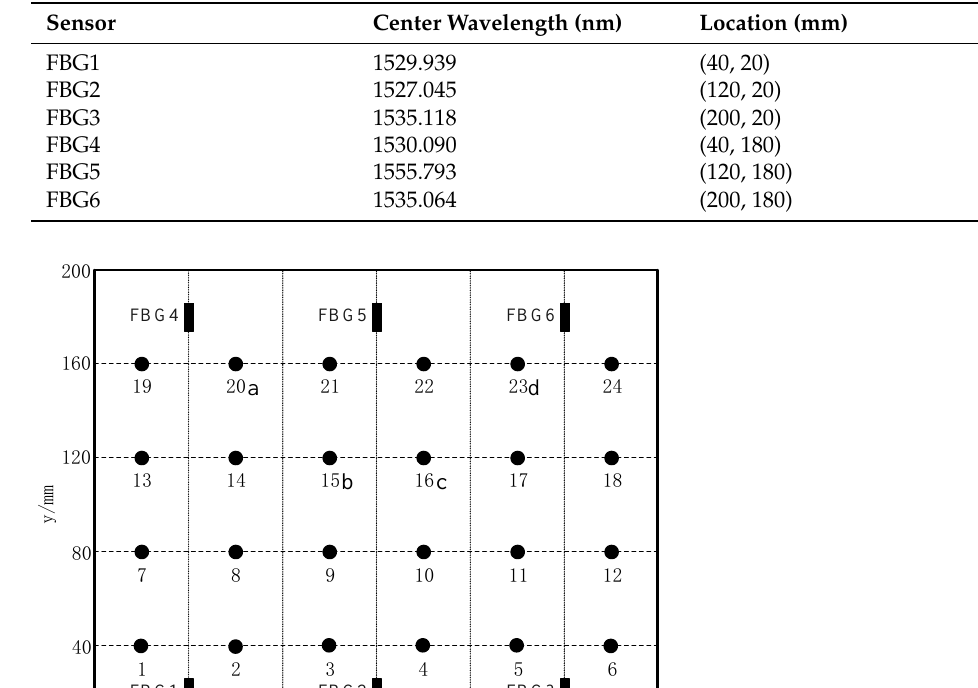
Figure 3. Layer thickness variation of composite laminate on specimen surface. Table 3. Grating wavelength and position.